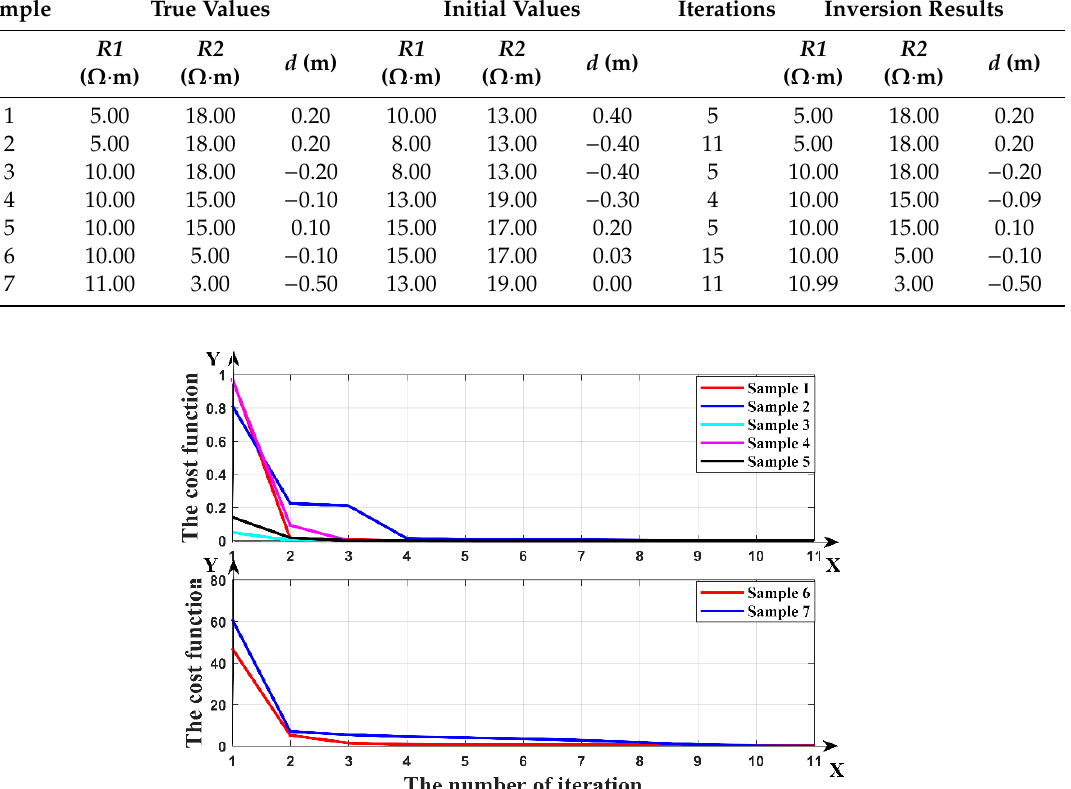
Table 3. Results of three-parameter inversion in the two-layer formation model. Sample